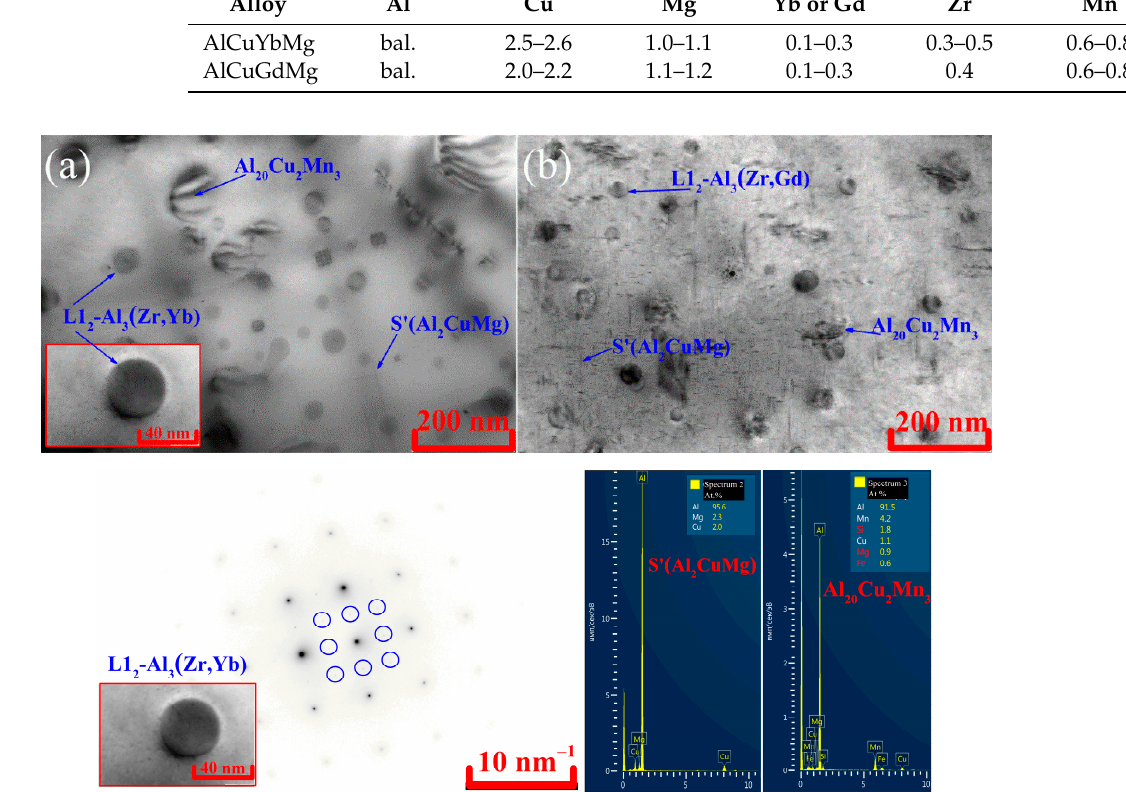
Figure 4. Microstructures of the ( a ) AlCuYbMg and ( b ) AlCuGdMg alloys after 3 h of solution treatment at ( a ) 555 ◦ C and ( b ) 565 ◦ C (SEM-BSE). Table 3. Composition of the Al solid solution after 3 h of solution treatment . the microstructure (Figure 5). The average sizes of the L1 2 -Al 3 (Zr,Yb) and L1 2 -Al 3 (Zr,Gd) precipitates are 28 ± 6 nm and 32 ± 4 nm, respectively (Figure 4). For comparison, the precipitates sizes in the AlCuYbZrMn and AlCuGdZrMn alloys after solution treatment Alloy at 590 and 605 °C are 38 ± 10 nm and 45 ± 16 nm [19]. Al 20 Cu 2 Mn 3 phase precipitates formed with a finer size of 100–200 nm in comparison with the same particles in the Mg-free alloys [24].